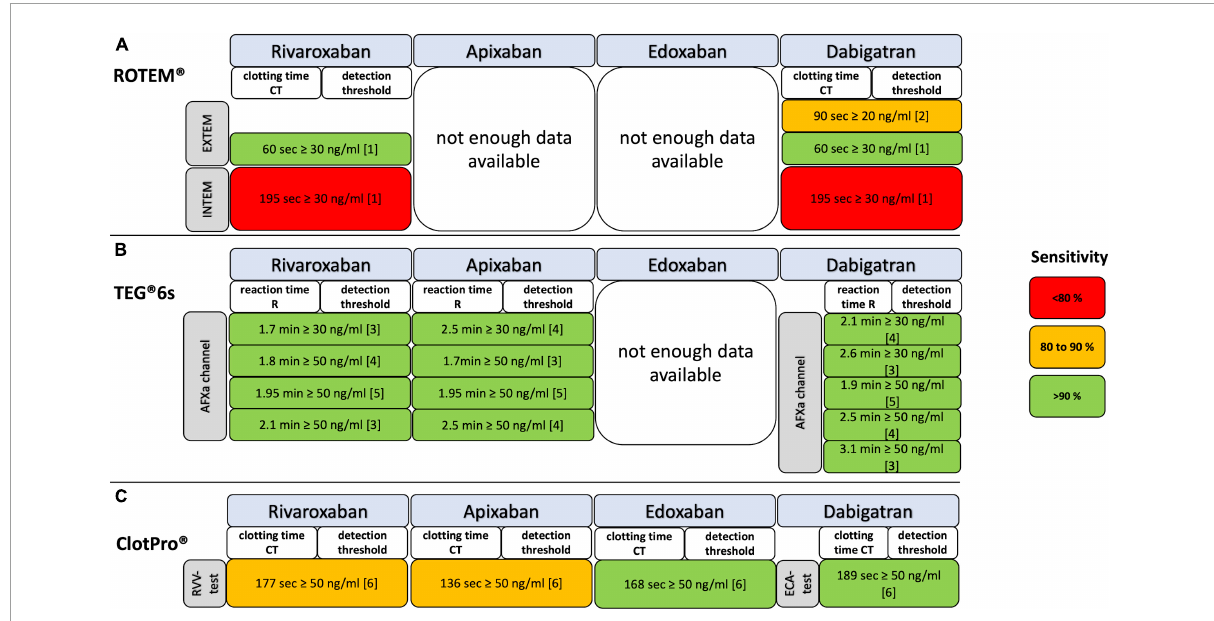
FIGURE5 Detection of residual DOAC plasma concentrations with ROTEM, TEG, and ClotPro assays coded for test accuracy by sensitivity. (A) EXTEM, ROTEM assay extrinsic activated; INTEM, ROTEM assay intrinsic activated; NATEM, ROTEM assay natively activated; (B) DTI, direct thrombin inhibitor channel of TEG 6s; AFXa, anti-factor-Xa channel of TEG 6s; (C) ECA, ecarin-activated ClotPro test; RVV, Russell’s viper venom-activated ClotPro test. References: [1] Henskens et al. (30); [2] Taune et al. (69); [3] Artang et al. (21); [4] Artang et al. (20); [5] Bliden et al. (22); [6] Oberladstätter et al.